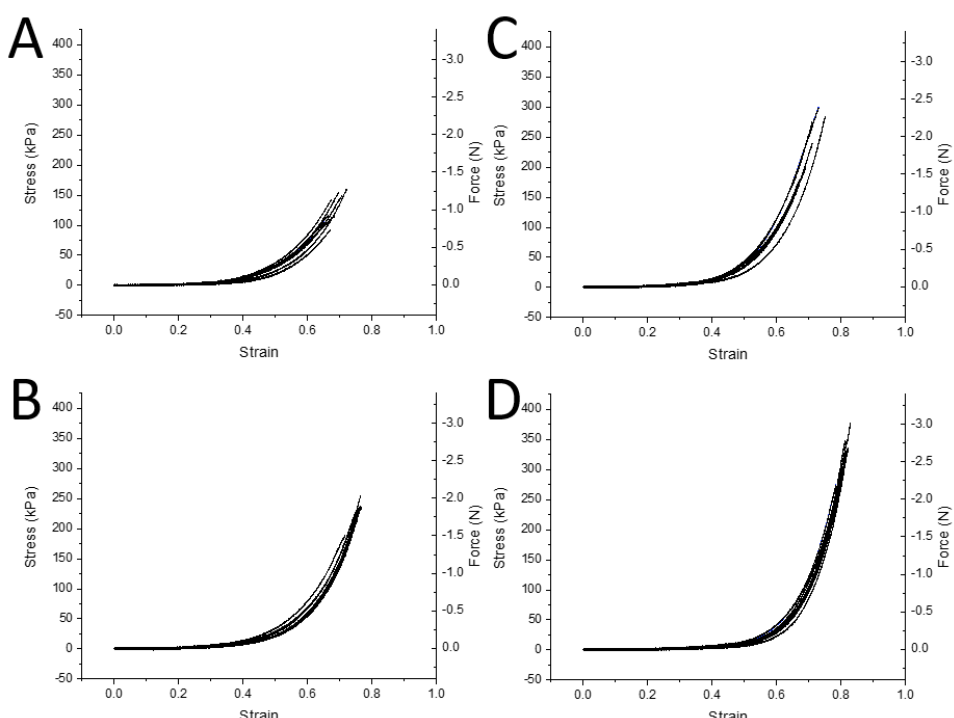
Figure 4. Mechanical properties in compression of collagen-GMA hydrogel at varying weight percent (wt.%). Stress-strain graphs of collagen-GMA hydrogel at ( A ) 0.8, ( B ) 0.9, ( C ) 1.0 and ( D ) 1.1 wt.%. Force has been added as a second Y -axis. n = 6 – 8.